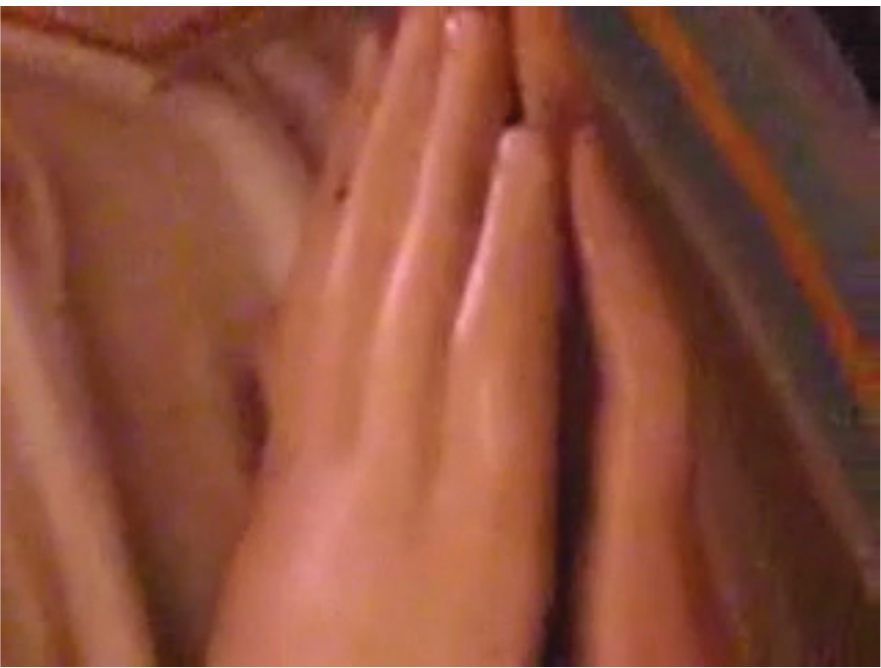
Figure 3. Confession Diptych (2007). Digital film still: the inside of Freeman’s childhood church paired with manic carnival ride audio